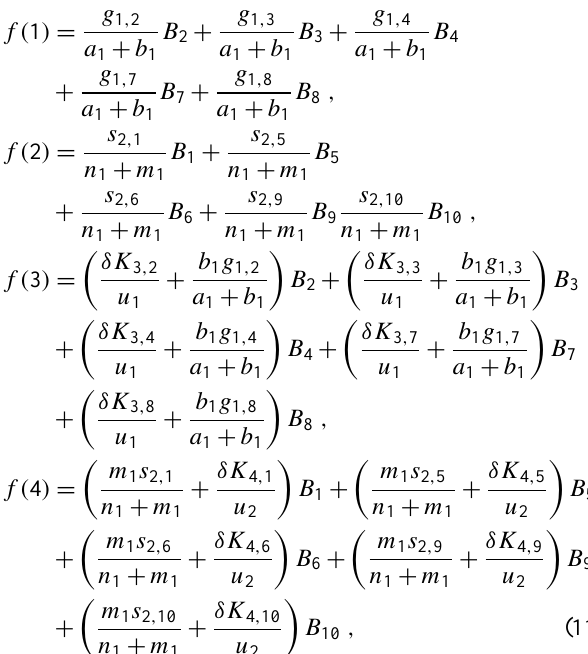
1000kgm − 3 , one gets values (once normalized by f 0 ) in the range [ 0 . 0001 , 0 . 01 ] . Note that C in Eq. ( 6) is equivalent to C = | V | ρ a C D